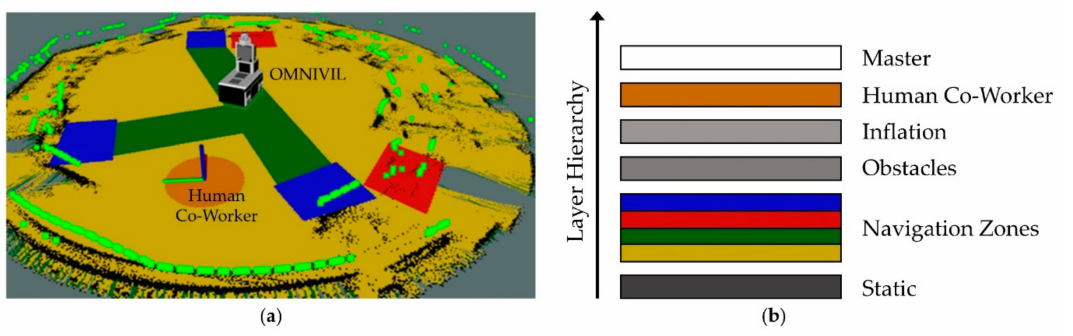
Figure 11. Navigation concept. ( a ) Zone setup without inflation layers; ( b ) costmap